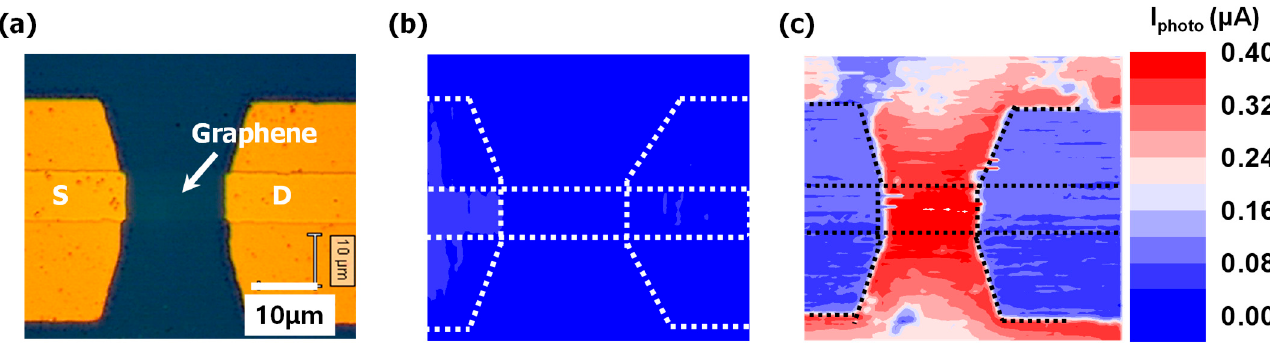
Figure 6. Scanning photocurrent mapping (SPCM) image of the Bi 2 Te 3 NWs/graphene junction photodetector and graphene photodetector ( a ) optical image of the graphene photodetector device, and SPCM image of ( b ) the graphene photodetector and ( c ) Bi 2 Te 3 NWs/graphene junction photodetector. The boundary of the source/drain metals and graphene channel are illustrated by a dotted